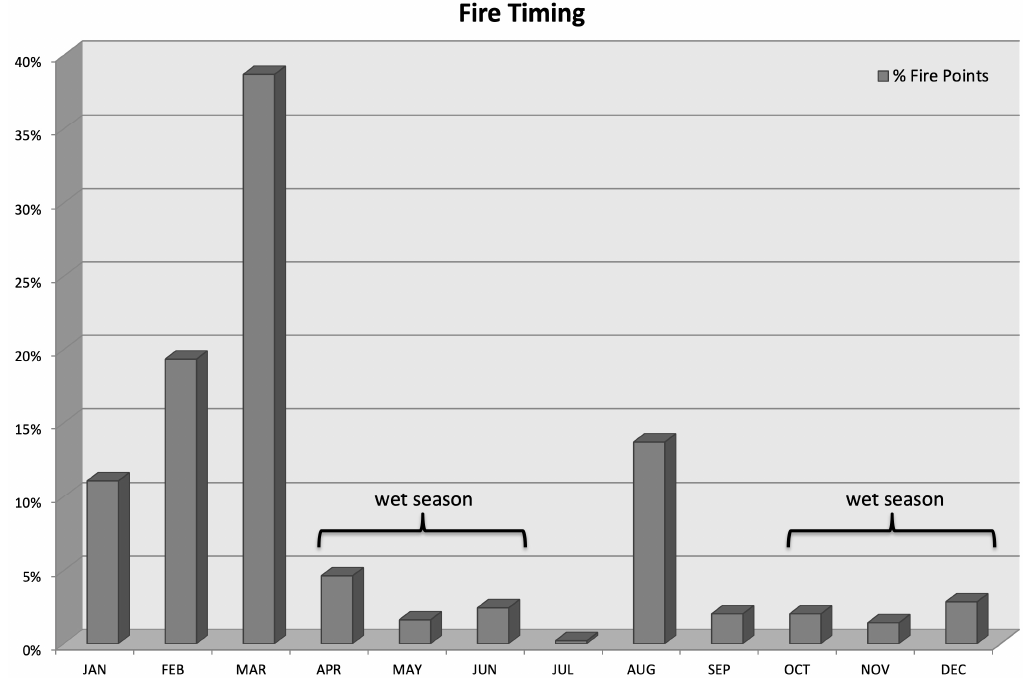
Figure 2. Distribution of MODIS active fire detection points by month, including rainfall timing.